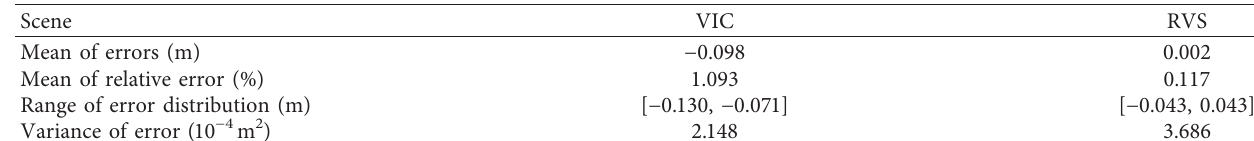
Table 5: Error statistics in the